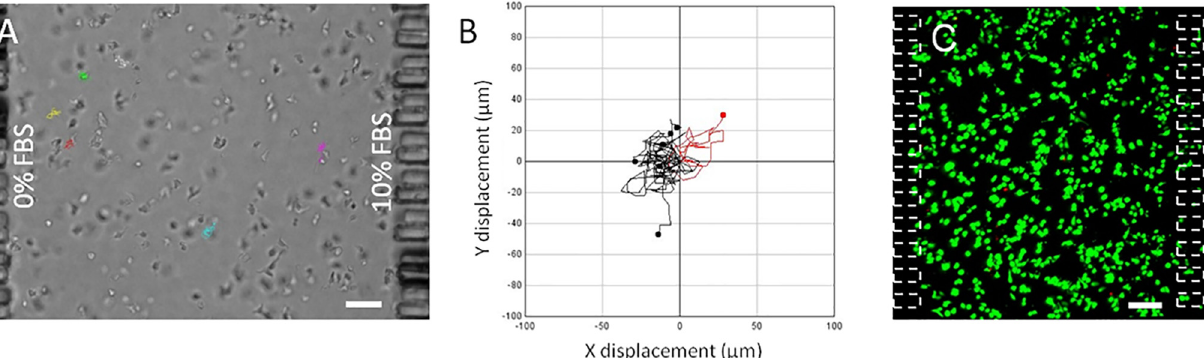
Fig 7. Chemotactic behavior of OSC – 19 individual cells. (A) Individual OSC – 19 cells were embedded in collagen hydrogel within the central microchamber. Media supplemented with 10%FBS was perfused through one lateral microchannel, whereas basal media was used in the other. Tracks of migrating cells are shown. (B) Individual cell trajectories are plotted, showing those with a net displacement to the right in red, and those displaced to the left in black. (C) Isolated OSC – 19 cell viability after 30 hours under gradient conditions, viable cells are shown in green. Scale bar is 100 μ m.